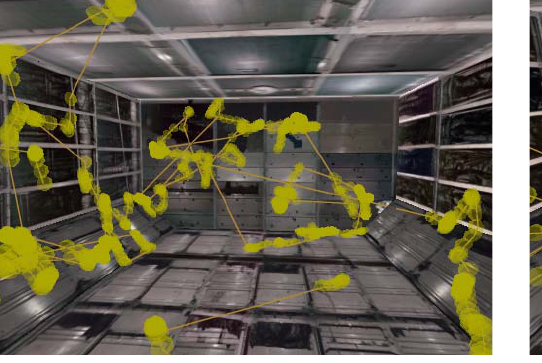
Figure 6. “Fixation Points for M.F.F”. Figure 7. “Fixation Points for F.F.S”.